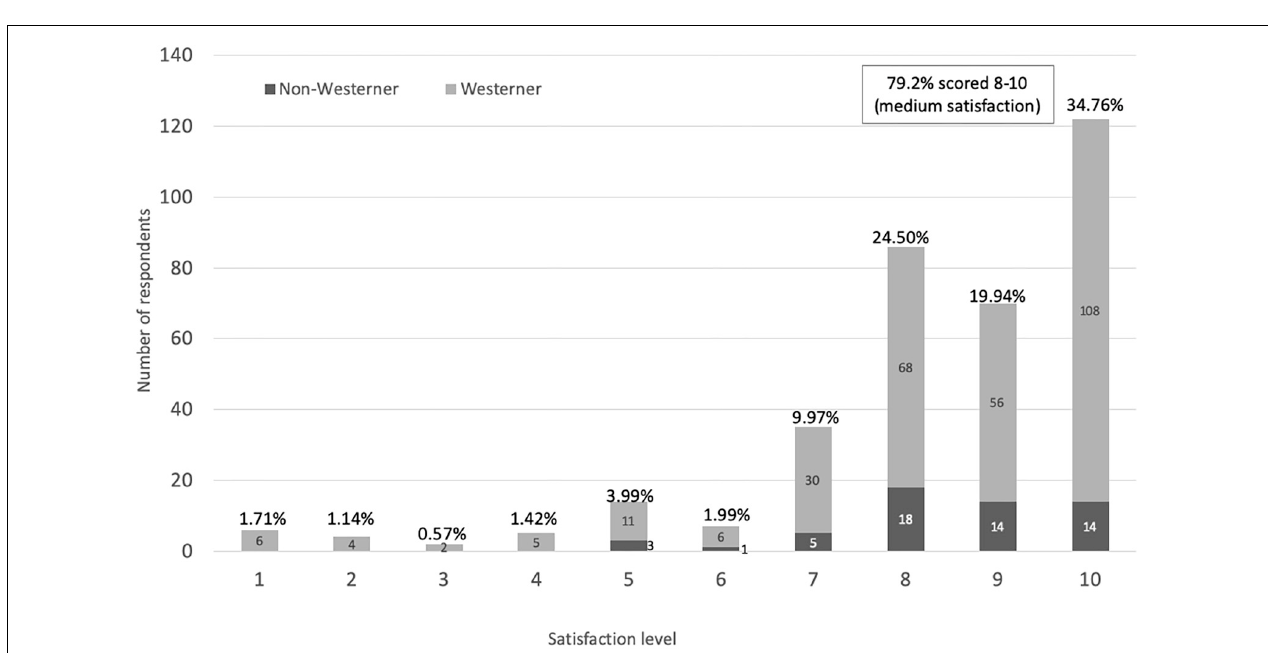
FIGURE 3 | Satisfaction level of tourist respondents (79.2% respondents scored 8–10, n = 351). Overall medium satisfaction (Hanan and Karp, 1989), edging toward high if also considering Pearce (2006) benchmark. Percentage covers both Westerners and non-Westerners.